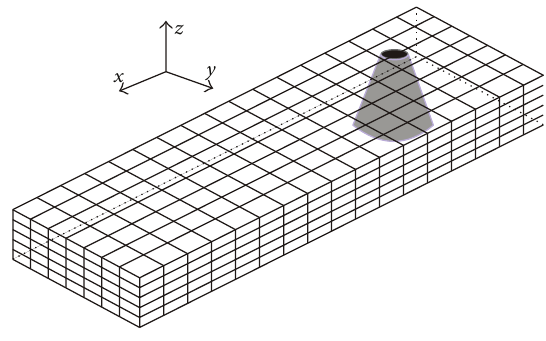
Figure 6: Computational domain discretization.